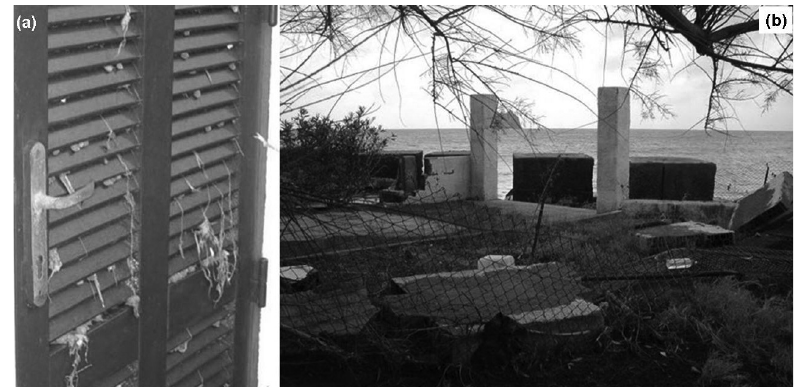
Fig. 11. Two pictures of building #4 (Punta Lena, Stromboli – Fig. 6), taken after the 2002 tsunami. (a) A door on the seaward wall of the building. The inundation did not break it down, but penetrated through the shutter openings and flooded the ground-floor. The building was protected by the vegetation in the front garden (b) , some concrete works (a small wall and a table) and by the costal defences along the shoreline (concrete cubic rocks). The PTVA-3 Model classified this building as having a “low” RVI.